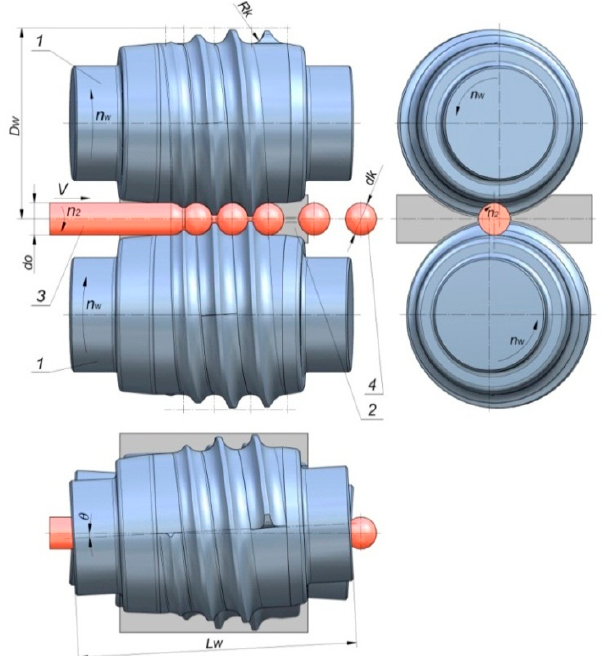
Figure 1. View of the helical rolling process for balls: 1—rolls with helix grooves, 2—guide plates, 3—workpiece, 4—manufactured ball.